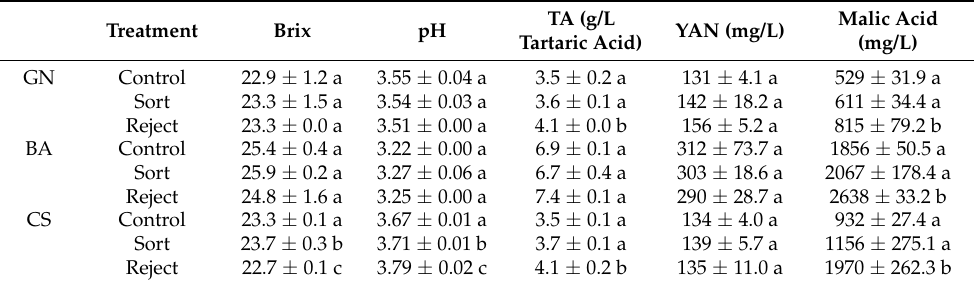
Table 4. Means and standard deviations for Brix, pH, titratable acidity (TA), yeast assimilable nitrogen (YAN), and malic acid of musts taken after processing and mixing and before any additions were made.